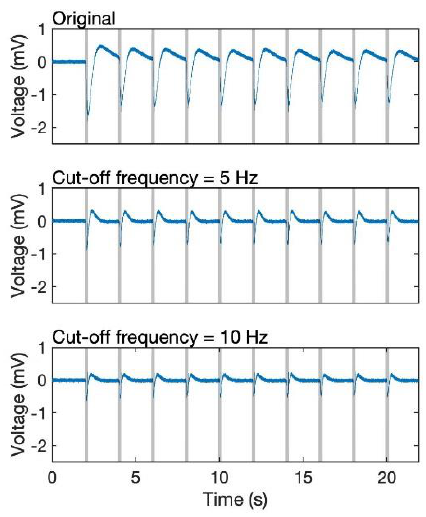
Figure 5. EAG signal passed through a high-pass filter. The original signal (type 2) sampled at 100 Hz (top), filtered at a cut-off frequency of 10 Hz (middle) and 5 Hz (bottom).